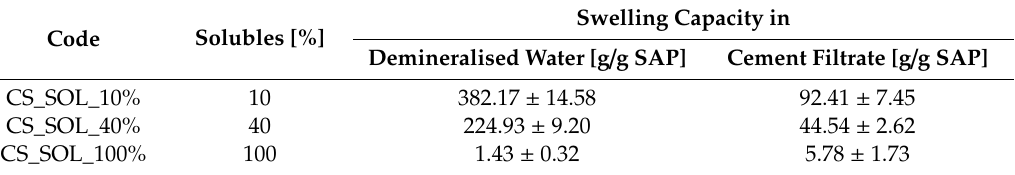
Table 5. Characterization of SAPs: solubles (%), swelling capacity in demineralised water and cement filtrate (g / g SAP), n = 3, Series 3.